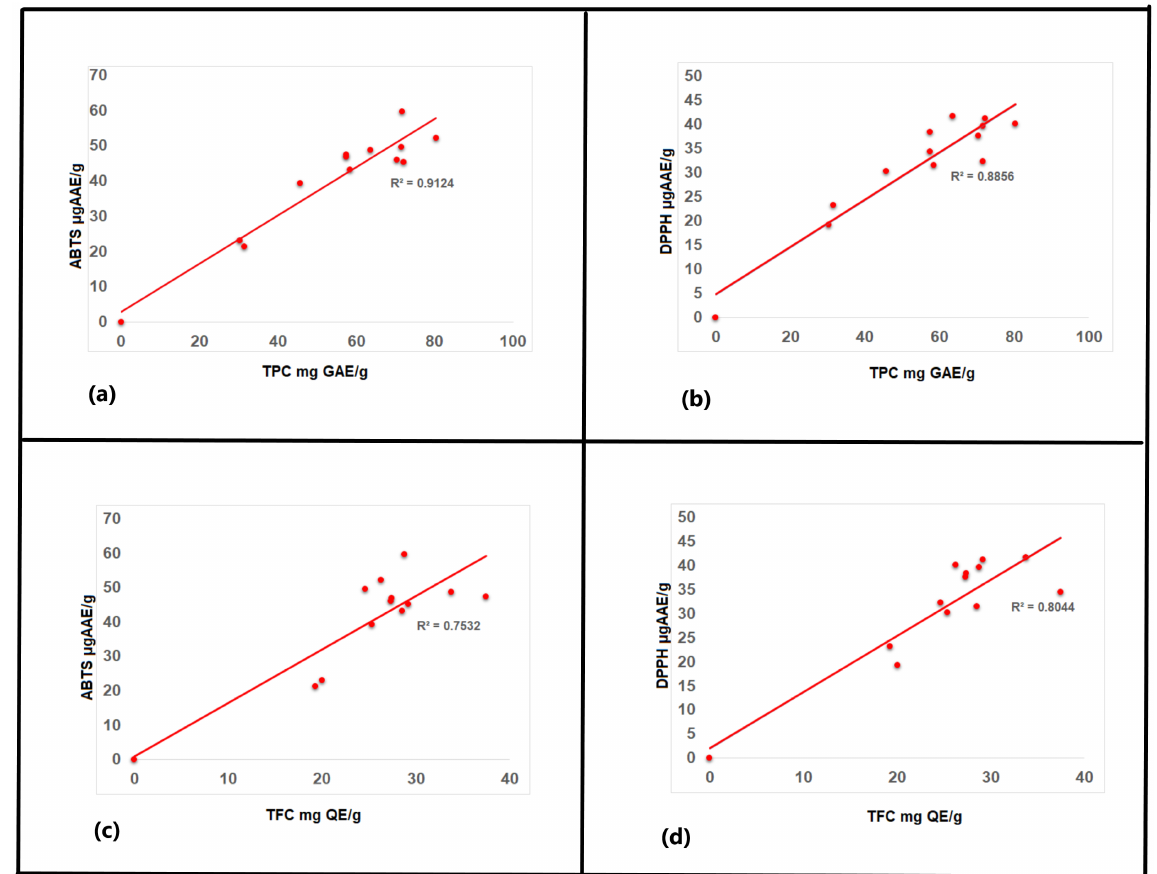
Figure 10. Correlations between the antioxidant activity, total phenolic content, and total flavonoid content in Amaranthus hybridus. ( a ) TPC v / s ABTS, ( b ) TPC v / s DPPH, ( c ) TFC v / s ABTS, and ( d ) TFC v / s DPPH.